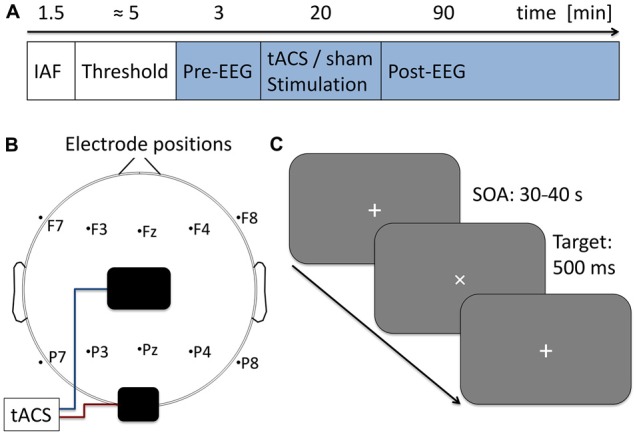
Experimental procedure. (A) Time course of the current experiment. First 90 s of eyes-closed EEG were acquired to determine participants’ individual alpha frequency (IAF) which was used as stimulation frequency in the subsequent steps. Next, stimulation intensity was adjusted to the individual sensation threshold. During the following 113 min participants performed a visual vigilance task (indicated in blue) while 3 min of baseline EEG was measured followed by 20 min of tACS or sham stimulation and 90 min post-stimulation EEG. (B) Electrode setup. Stimulation electrodes were placed above Cz (5 × 7 cm) and Oz (4 × 4 cm) following the international 10–20 system. Additionally 10 EEG electrodes were positioned over five frontal and five parietal sides. (C) Visual vigilance task. Participants fixated a white cross at the center of a computer screen. Every 30–40 s the cross was rotated by 45° for a duration of 500 ms. Participants were given 2 s to manually respond to the rotation and received 0.05 € for each detected target. A total of 191 targets were presented during the experiment.